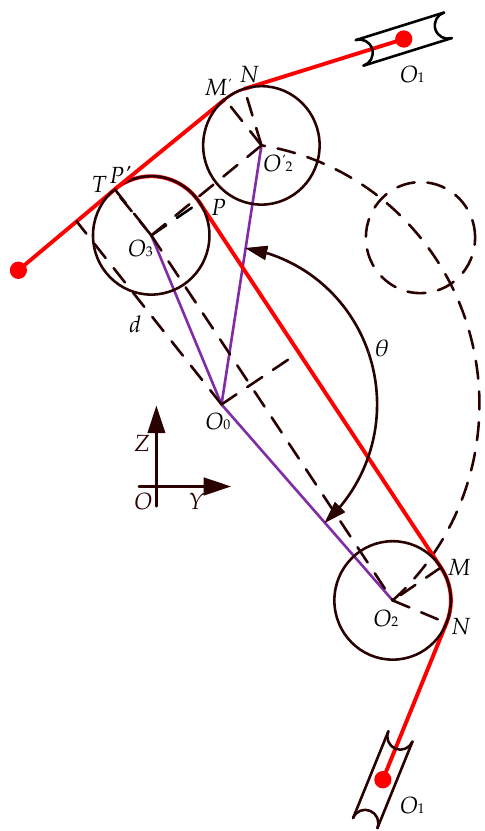
Figure 3. Equivalent model of deployable mechanism.